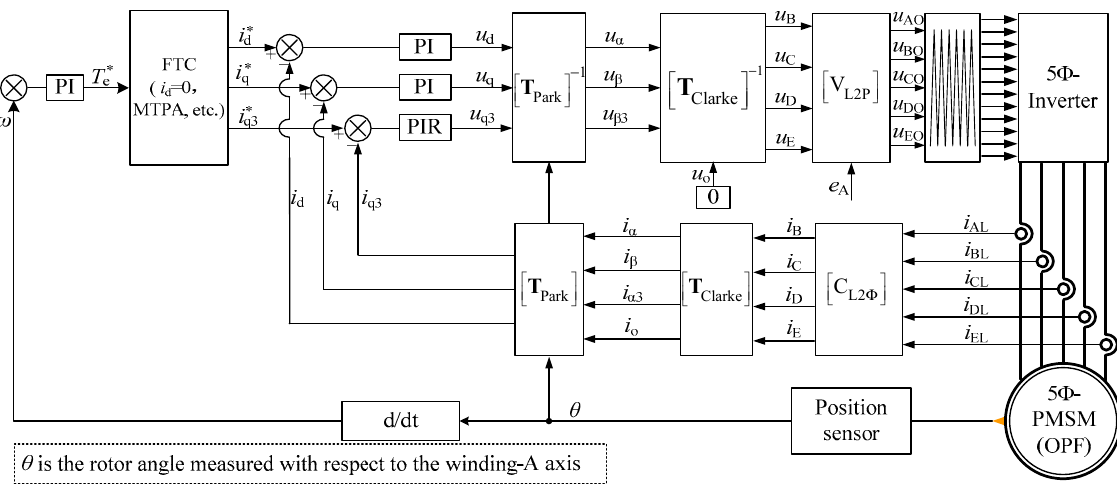
Figure 7. Block diagram of unified open-phase fault-tolerant control for all connection modes.